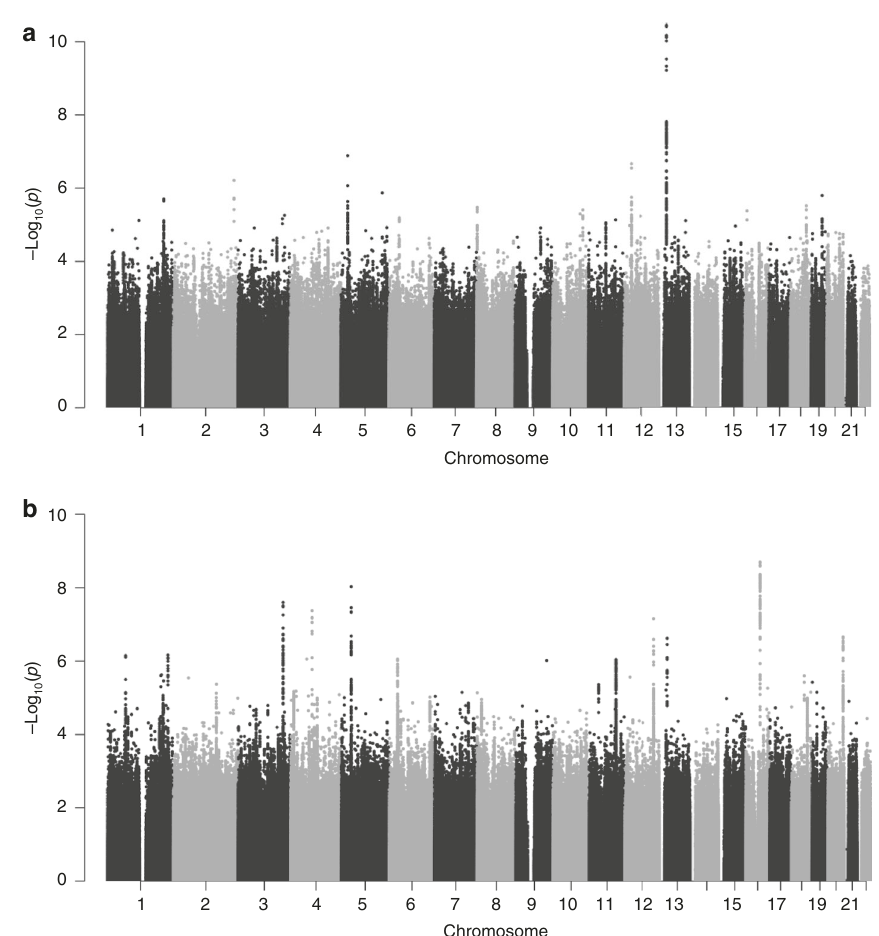
Fig. 1 Manhattan plots of genome-wide association results from the preeclampsia meta-analyses. P -values ( − log 10 ) from the meta-analysis are plotted against their respective positions on each chromosome. a Offspring of preeclamptic pregnancies from Europe and Central Asia (6775 cases and 375,372 controls). b Preeclamptic women from Europe and Central Asia (9515 cases and 157,719